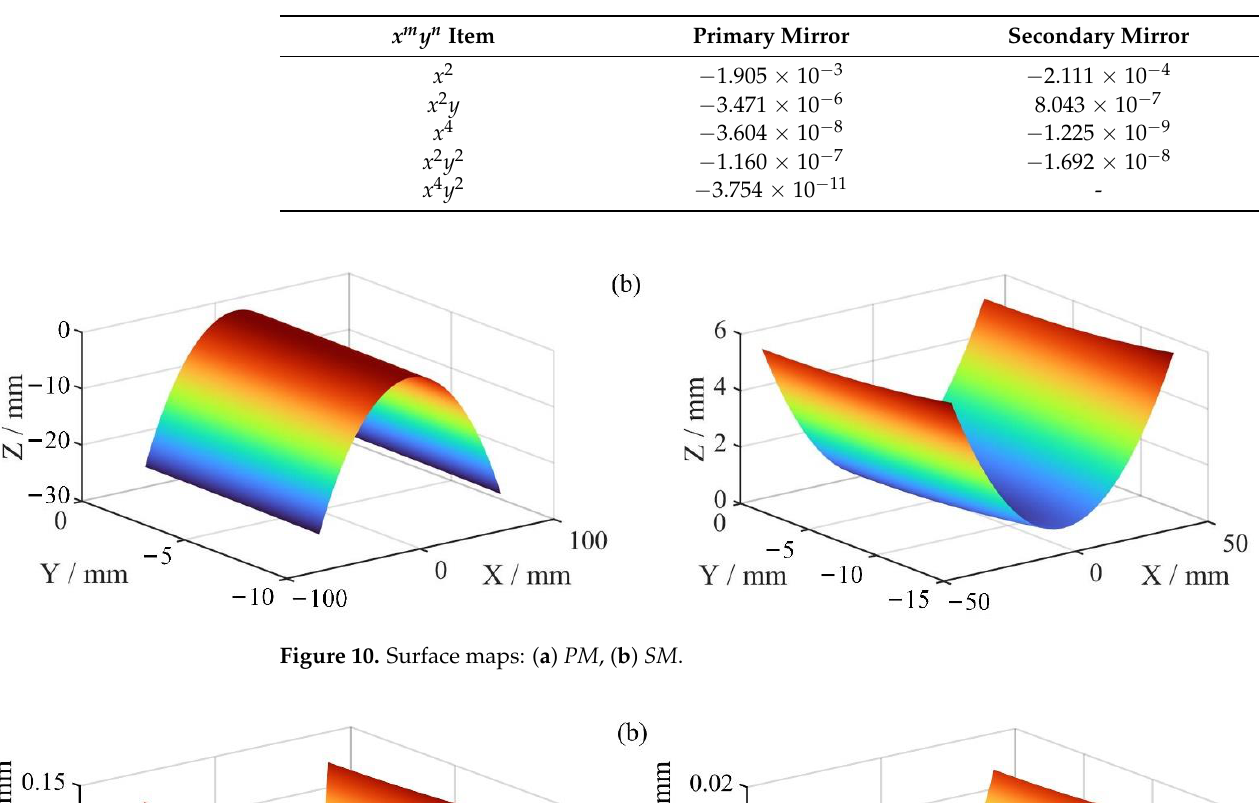
Table 2. Freeform surface coefficients.